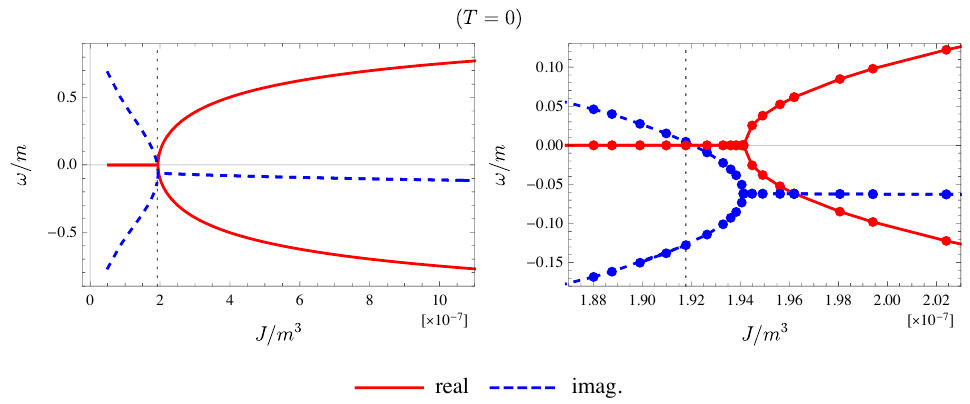
Figure 11 . (left) ω/m of the two poles pointed in figure 10 as functions of J/m 3 . The red solid line and the blue dashed line represent the real and imaginary part of ω , respectively. The dotted vertical line shows J/m 3 of the second turning point: J (2) /m 3 = 1 . 9178 × 10 − 7 . (right) An enlarged turn view of the left panel around J (2) /m 3 = 1 . 9178 × 10 − 7 turn